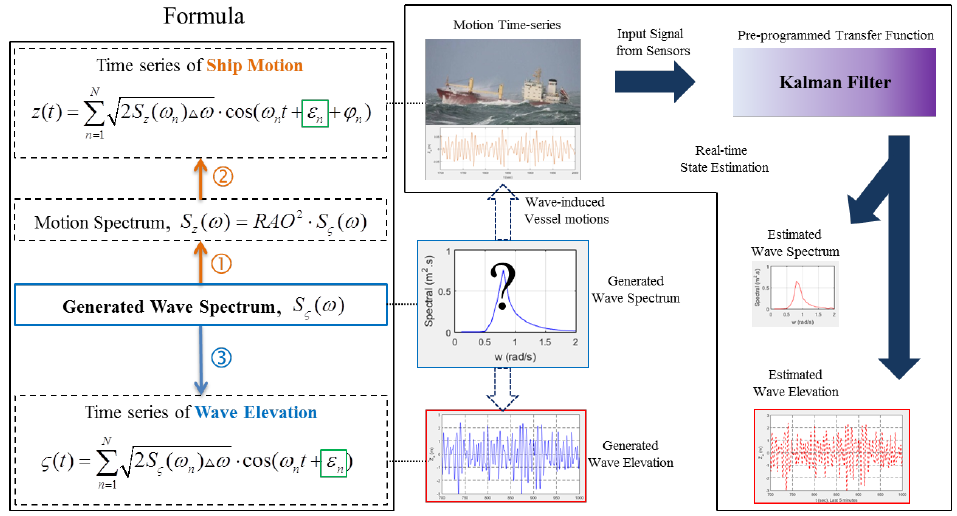
Figure 17. Wave elevation estimation process using Kalman filter and Formula.